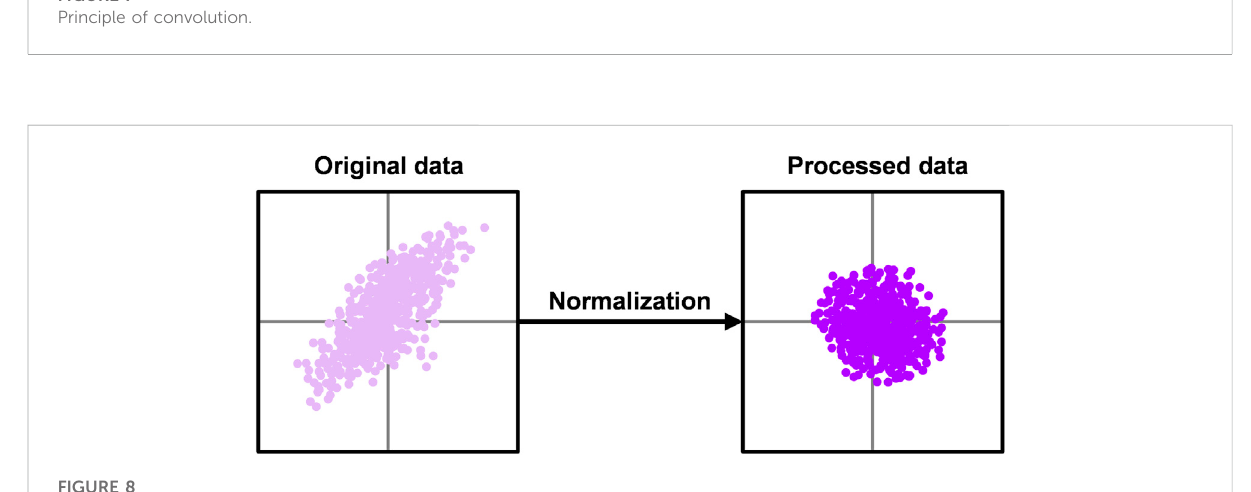
FIGURE 8 Principle of batch